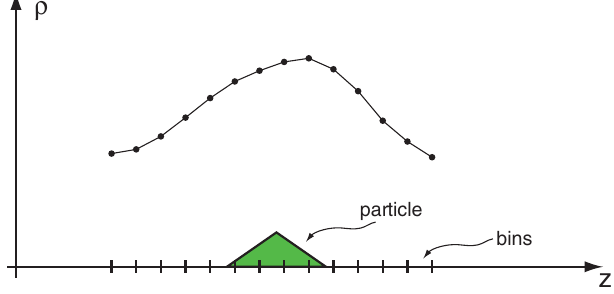
FIG. 6. (Color) Bmad implementation of the CSR algorithm. The beam of particles is divided up into a number of bins. The contribution of a particle to a bin’s total charge is determined by the overlap of the particle’s triangular charge distribution and the